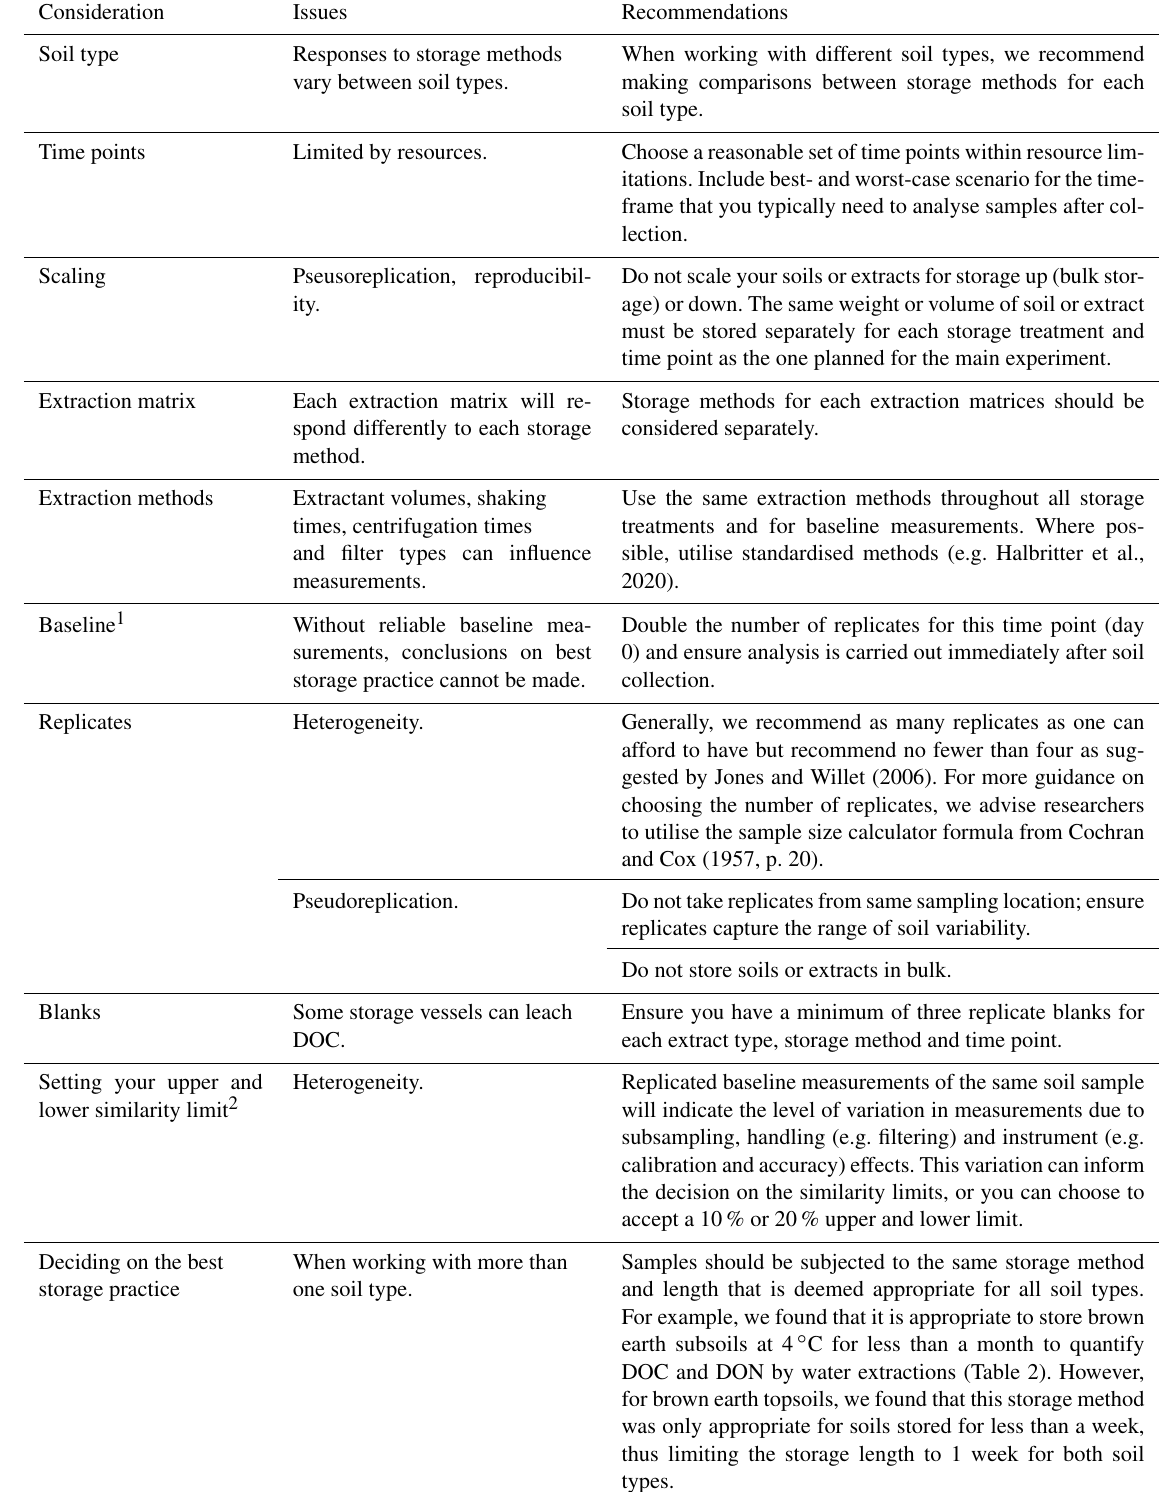
Table 3. Considerations to be made and their associated issues and recommendations when designing a pilot